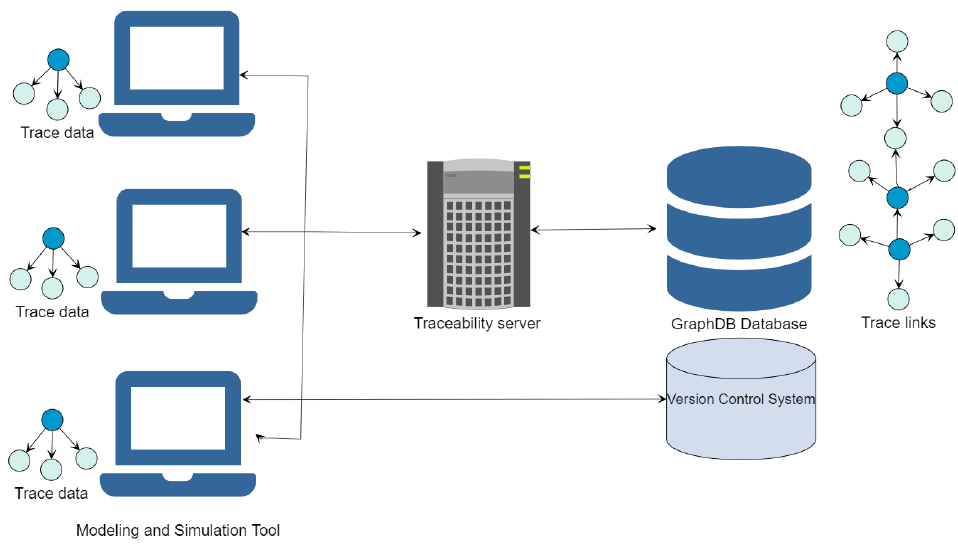
Figure 2. The architecture of the traceability